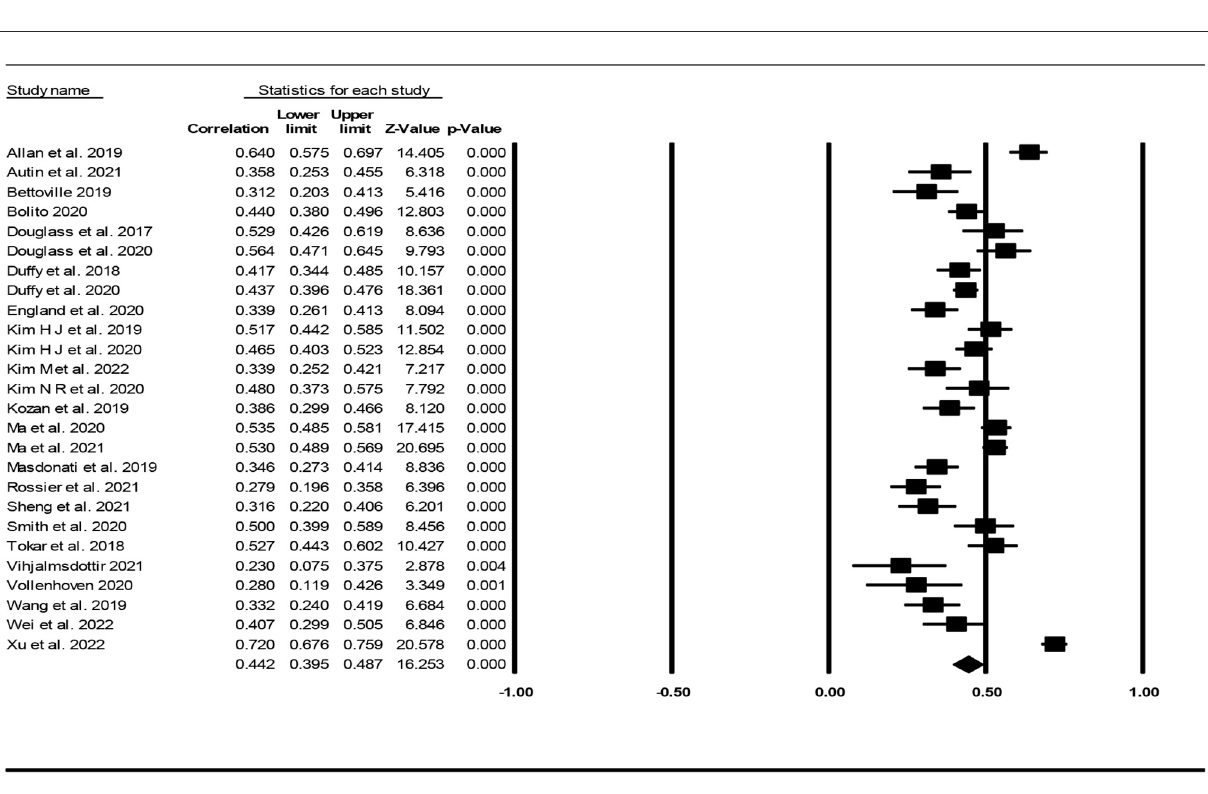
FIGURE3 Effect sizes of each study regarding the association between decent work and career